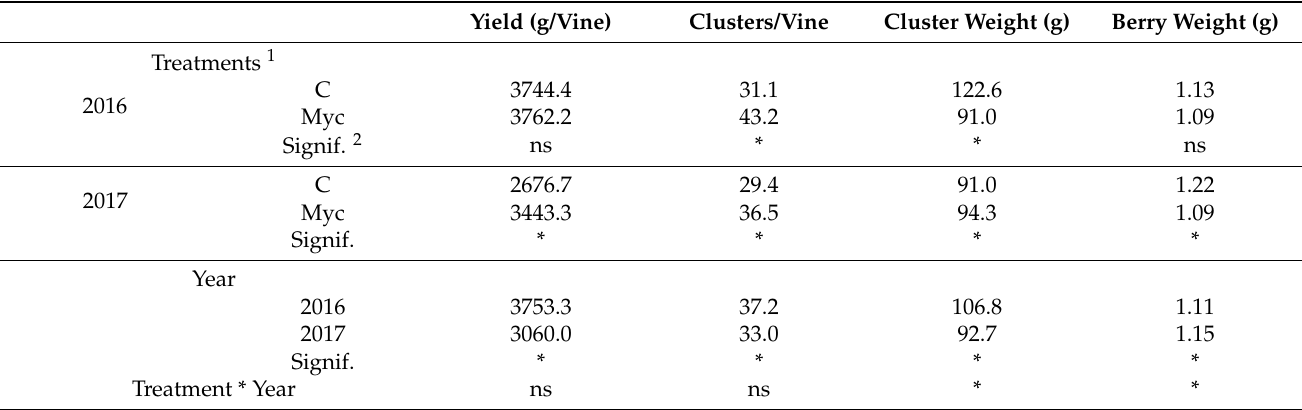
Table 3. Yield components in mycorrhized and control